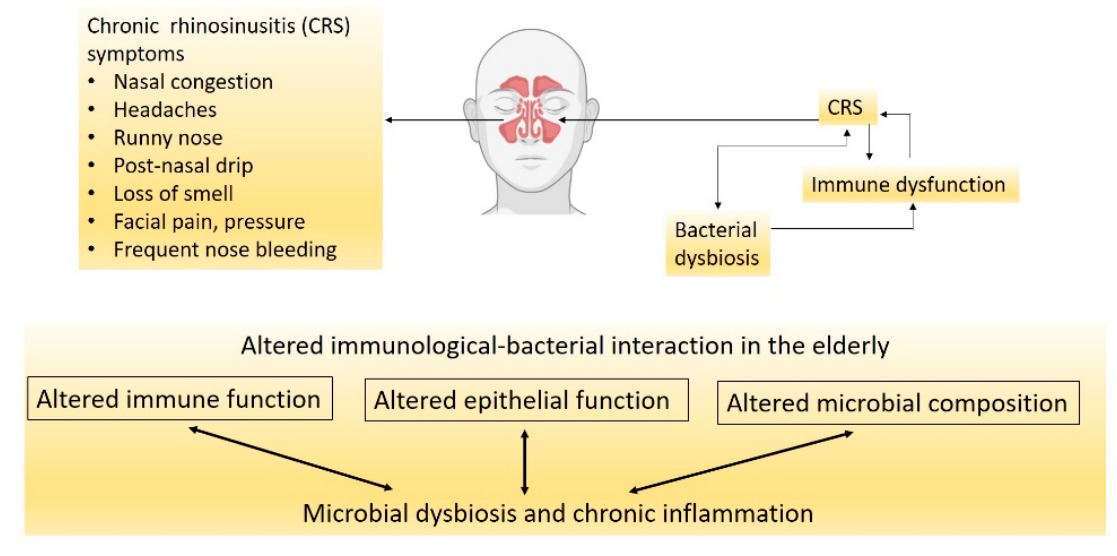
Figure 1. CRS is a multifactorial disease with the exact triggers not fully understood. Factors that cause bacterial dysbiosis could worsen with age by promoting immunological dysfunction.